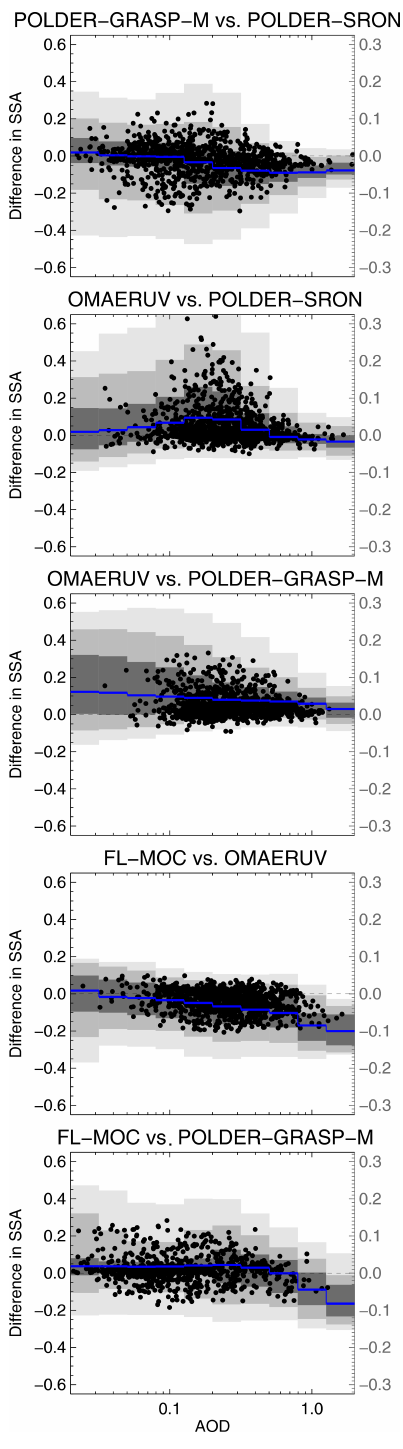
Figure 11. Difference in satellite product SSA as a function of AOD (averaged over both products). Two vertical axes are used: the left y axis is used for individual data points (subsampled), and the right y axis is used for the greyscale distribution (9%, 25%, 50%, 75% and 91% quantiles of the differences) and the median difference (blue line). Data were collocated within